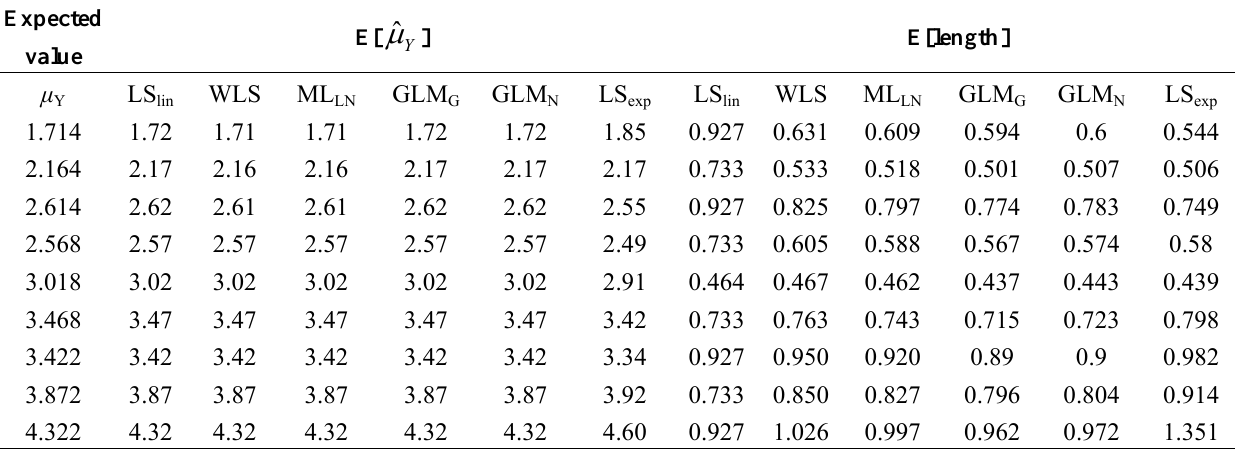
Table 2. Estimated expected value and expected length of 95% confidence interval for , for a sample of n = 108 observations (results from simulation with r = 10,000 replicates).